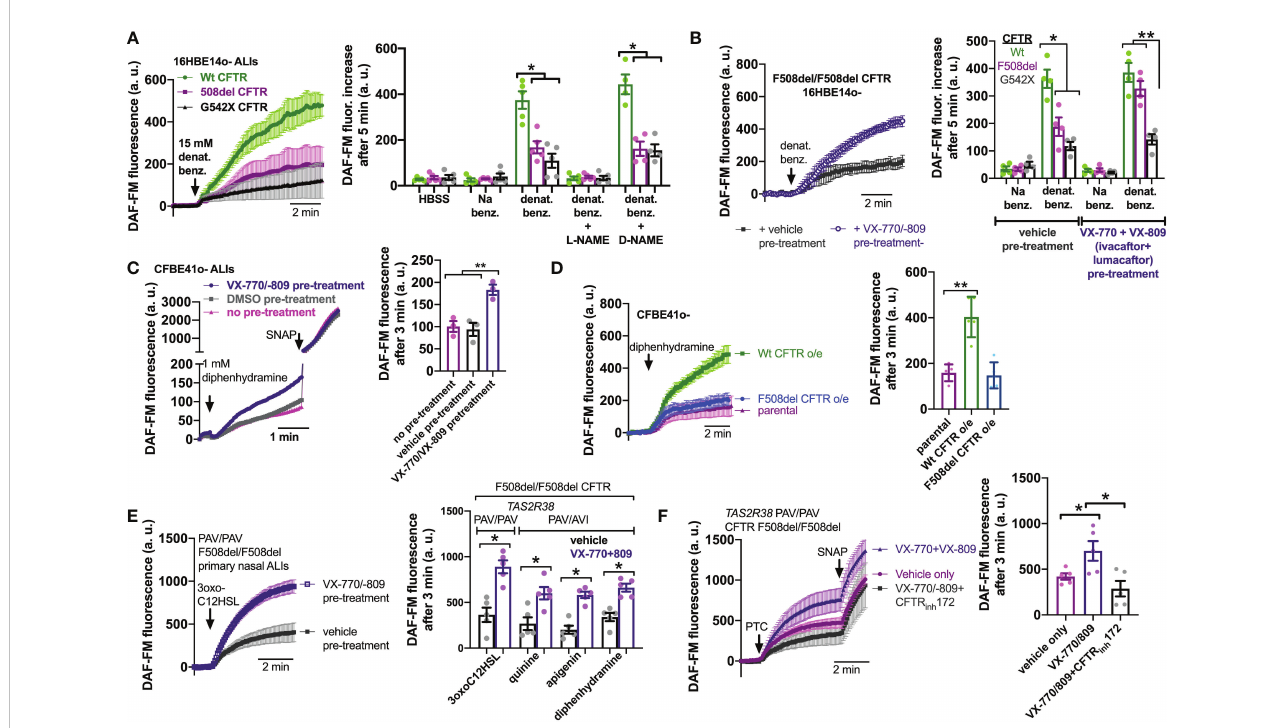
FIGURE 4 Loss of CFTR function reduces T2R-stimulated NO production in isogenic cell lines and restoration in cell lines and primary cells by CFTR corrector/ potentiator treatment. (A) Left, DAF-FM traces of nitric oxide (NO) production in response to multi-T2R agonist denatonium benzoate in 16HBE14o- air liquid interface cultures (ALIs) with Wt CFTR (parental line) or clones modi fi ed by CRISPR/Cas9 to have homozygous F508del/F508del or G542X/G542X CFTR. Right, bar graphs of DAF-FM fl uorescence changes in the three cell lines with T2R agonists denatonium ± NO synthase (NOS) inhibitor L-NAME